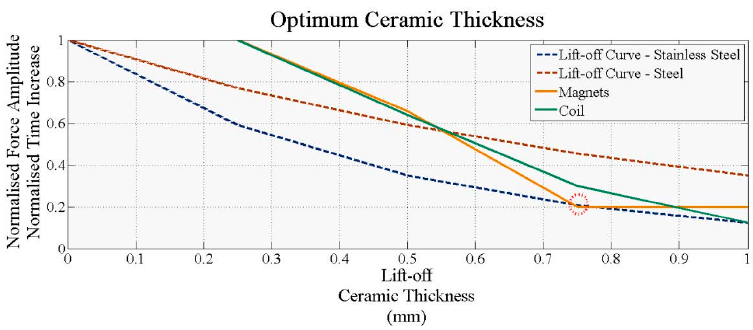
Figure 3. Optimum ceramic thickness graph.